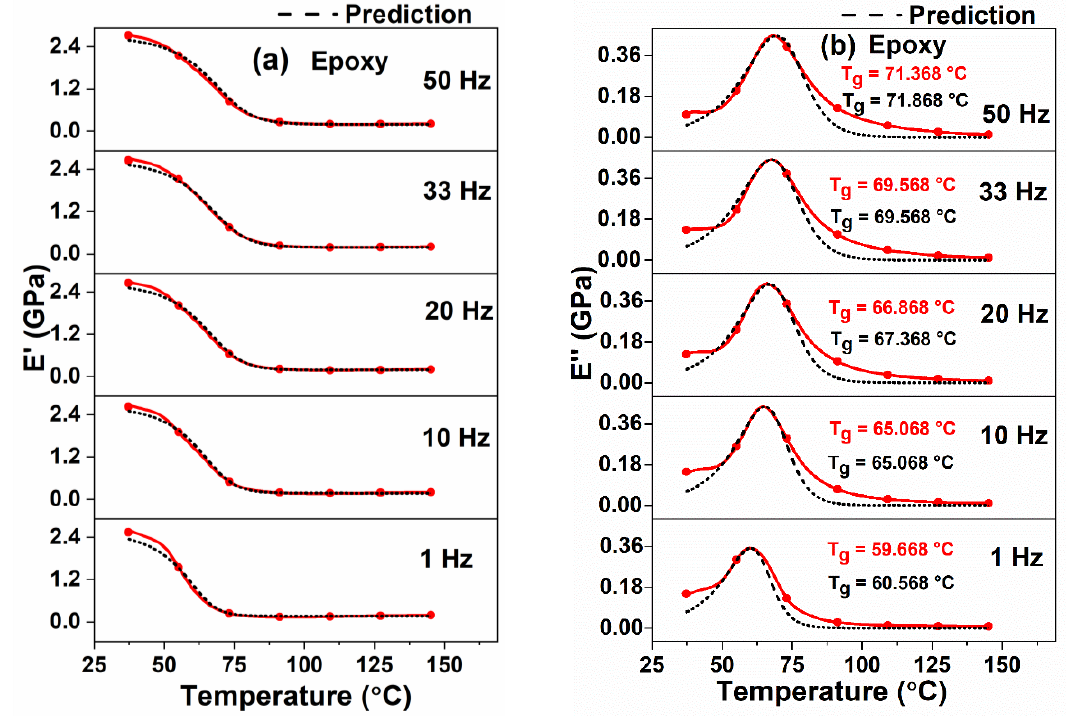
Figure 7. Comparison between predicted and experimental results for different frequencies of neat epoxy resin: ( a ) storage modulus and ( b ) loss modulus.